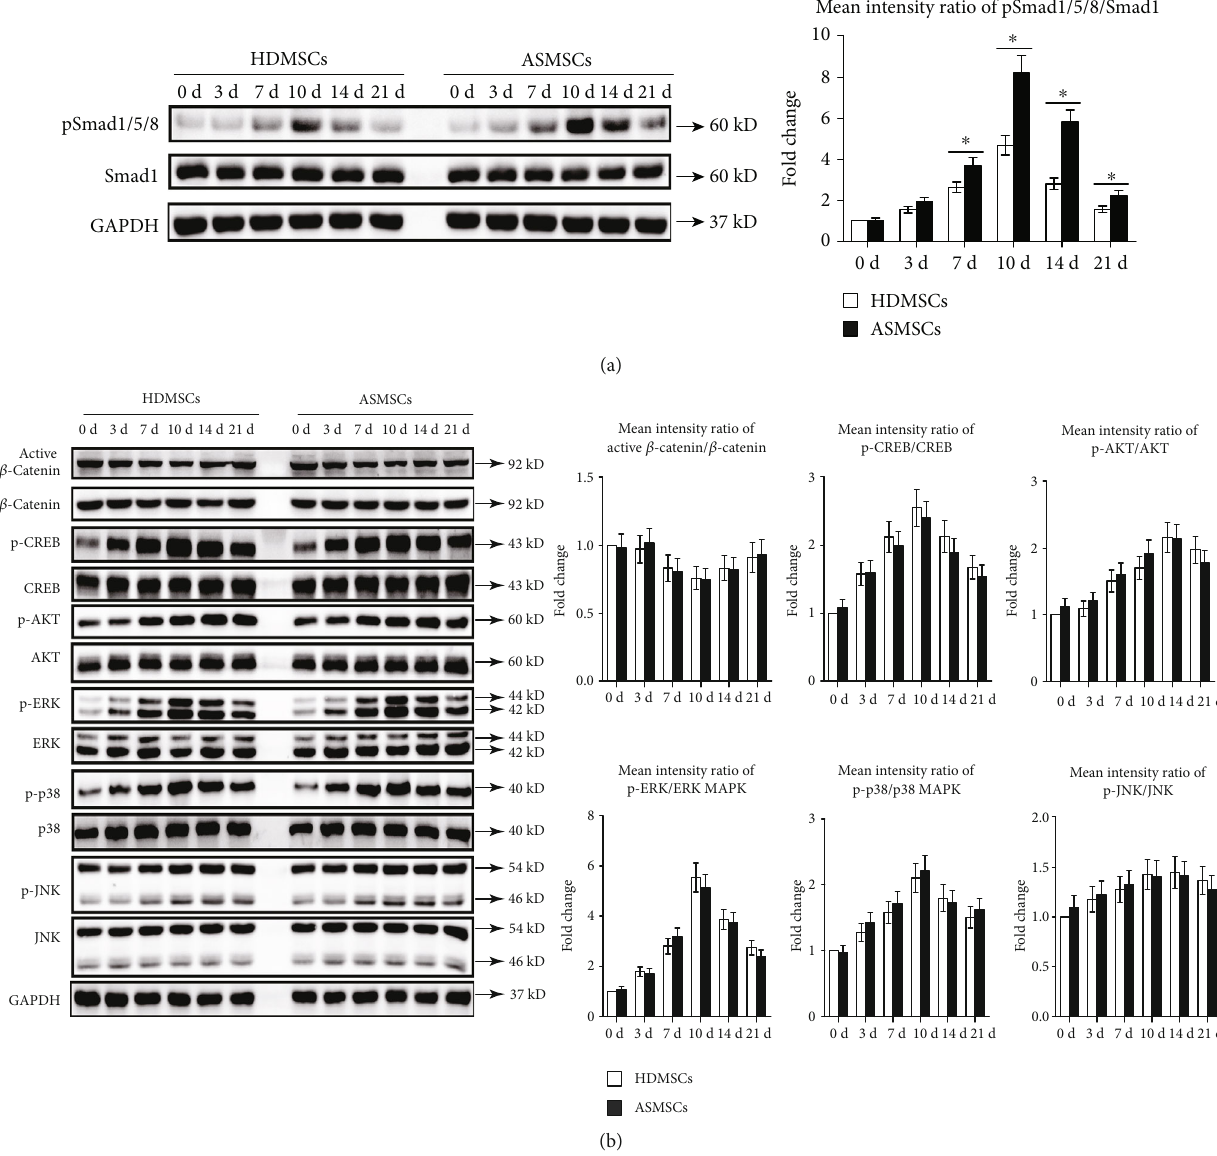
Figure 3: ASMSCs had higher pSmad1/5/8 expression during adipogenesis. The levels of proteins involved in adipogenic-related signaling pathways were assessed. (a) Higher levels of the pSmad1/5/8 proteins were detected in ASMSCs ( n = 25 ) than in HDMSCs ( n = 30 ) on days 7, 10, 14, and 21. (b) No di ff erences in the active β -catenin/ β -catenin, p-CREB/CREB, p-AKT/AKT, p-ERK/ERK, p-p38/p38, or p- JNK/JNK ratios were observed between HDMSCs and ASMSCs. Values are presented as the means ± SDs . ∗ P < 0 : 05 for the di ff erences between HDMSCs and